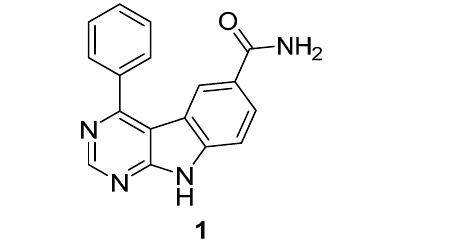
Figure 2. Most potent 9-H-pyrimido [4,5-b]ind-6-ol-based structure. 3.1.2. 7,3 ′ ,4 ′ -Trihydroxyiso fl avone (THIF)